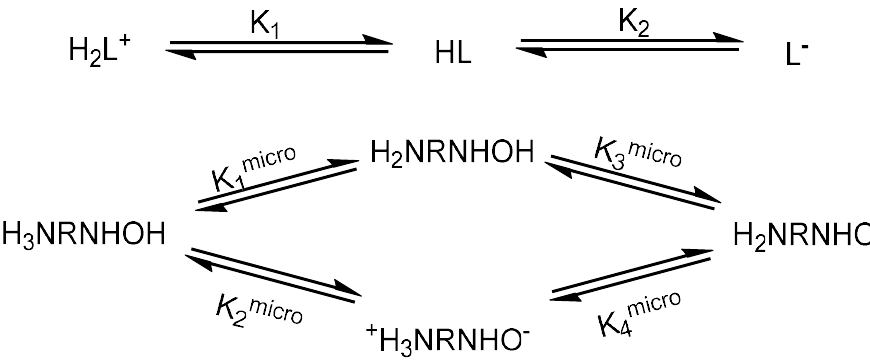
Figure 1. Macro and micro proton dissociation processes of aminohydroxamates together with the appropriate constants; for the values see Table 1.